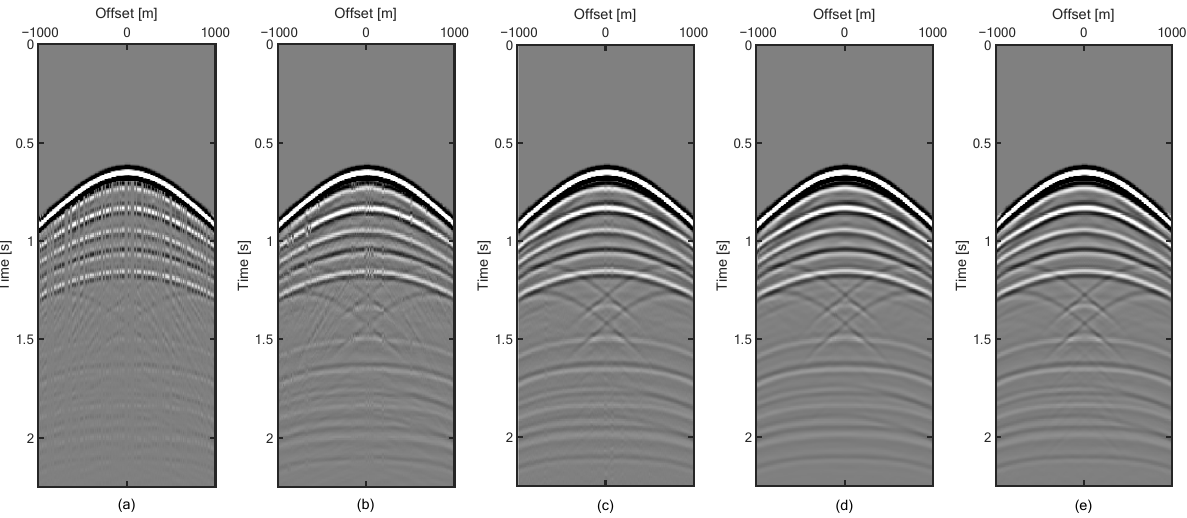
Figure 7. Comparison of focusing functions of the 100th iteration. ( a ) The focusing function without reconstruction, calculated by irregular sampling over the source dimension and integrating over the receiver dimension; ( b ) The reconstructed focusing function for sparse reconstruction in the wavelet domain; ( c ) The reconstructed focusing function for sparse reconstruction in Fourier domain; ( d ) The reconstructed focusing function for sparse reconstruction in curvelet domain; ( e ) The focusing function for reference.